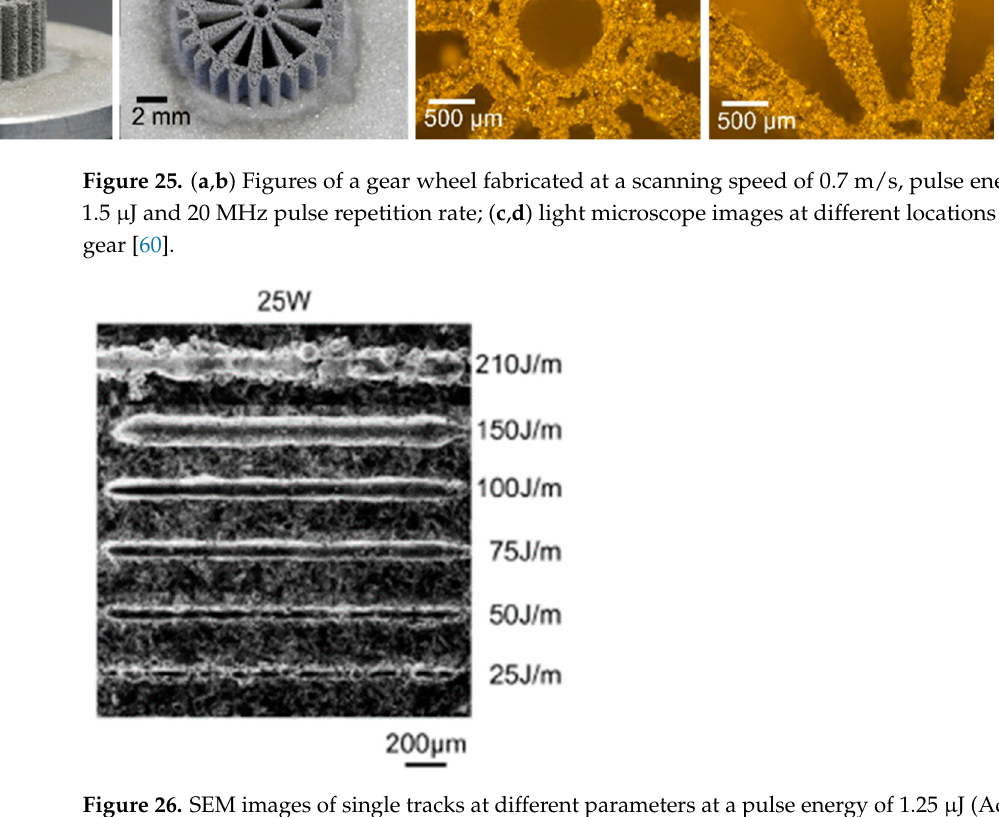
Figure 26. SEM images of single tracks at different parameters at a pulse energy of 1.25 µJ (Adapted from reference [38]).